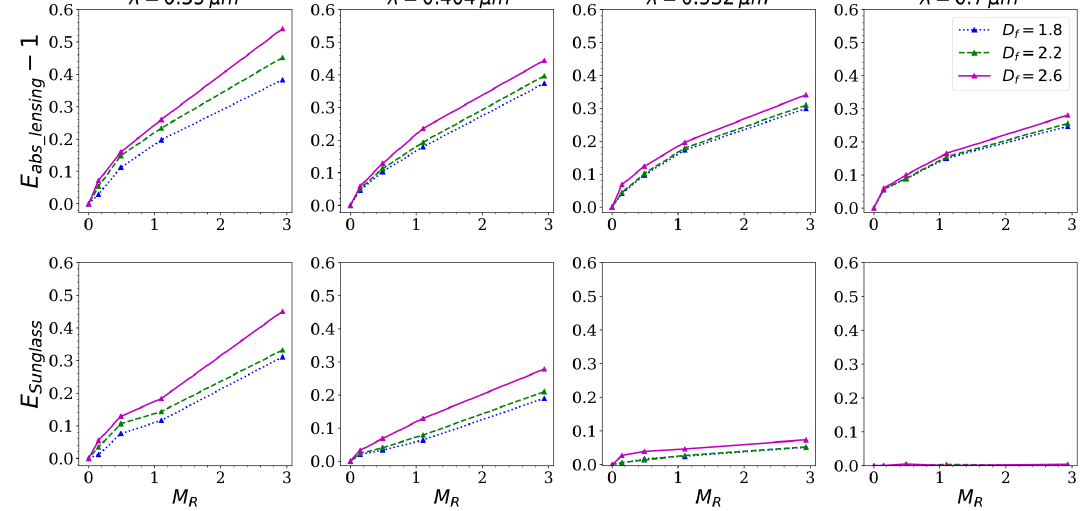
3.96 and 2.2 to 2.4 for λ = 0 . 532 and 0.7 µm,